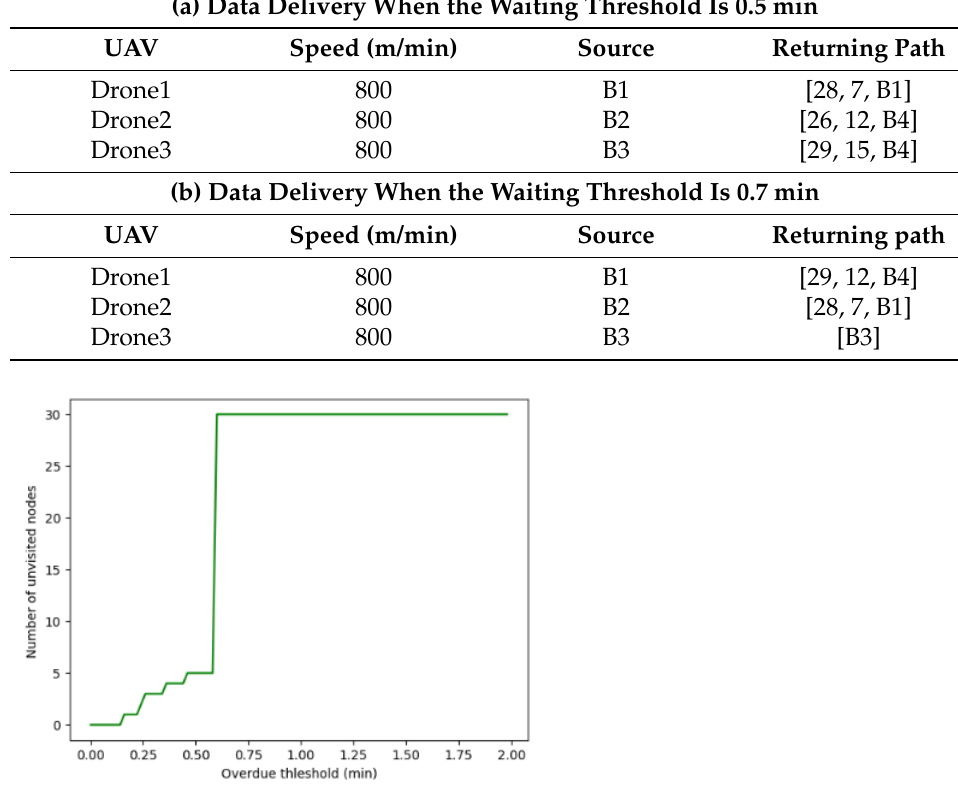
Figure 15. Variation of the number of unvisited nodes with respect to the overdue threshold.